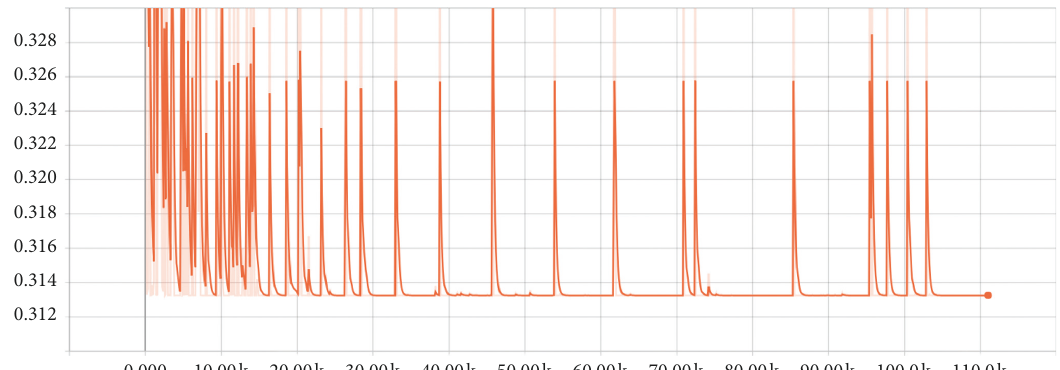
Figure 4: Printed loss value. Each iteration prints a loss of 100 times and evaluates the model once per 1000 iterations using the validation data set.